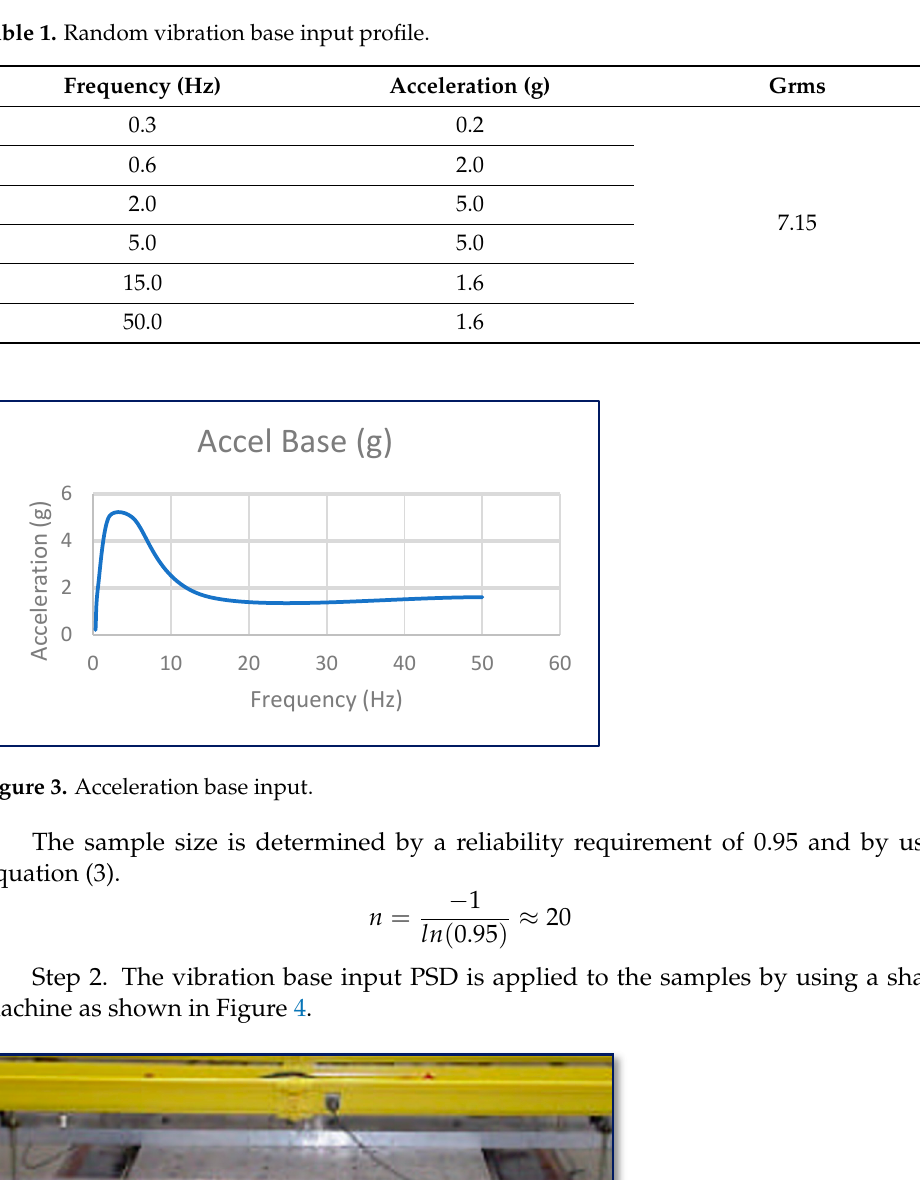
Table 2. Acceleration response.